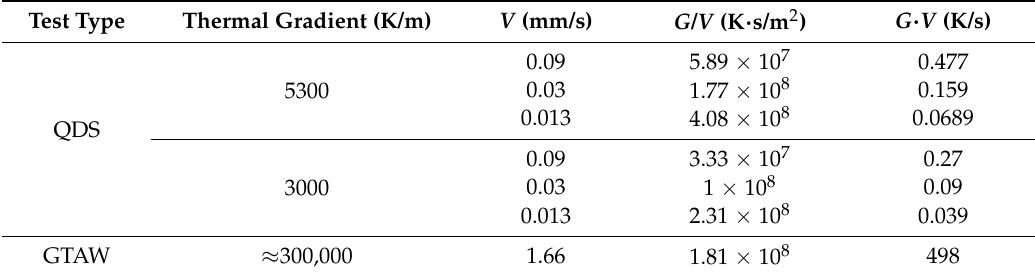
Table 3. Solidification parameters used in the quenched directional solidification (QDS) and welding